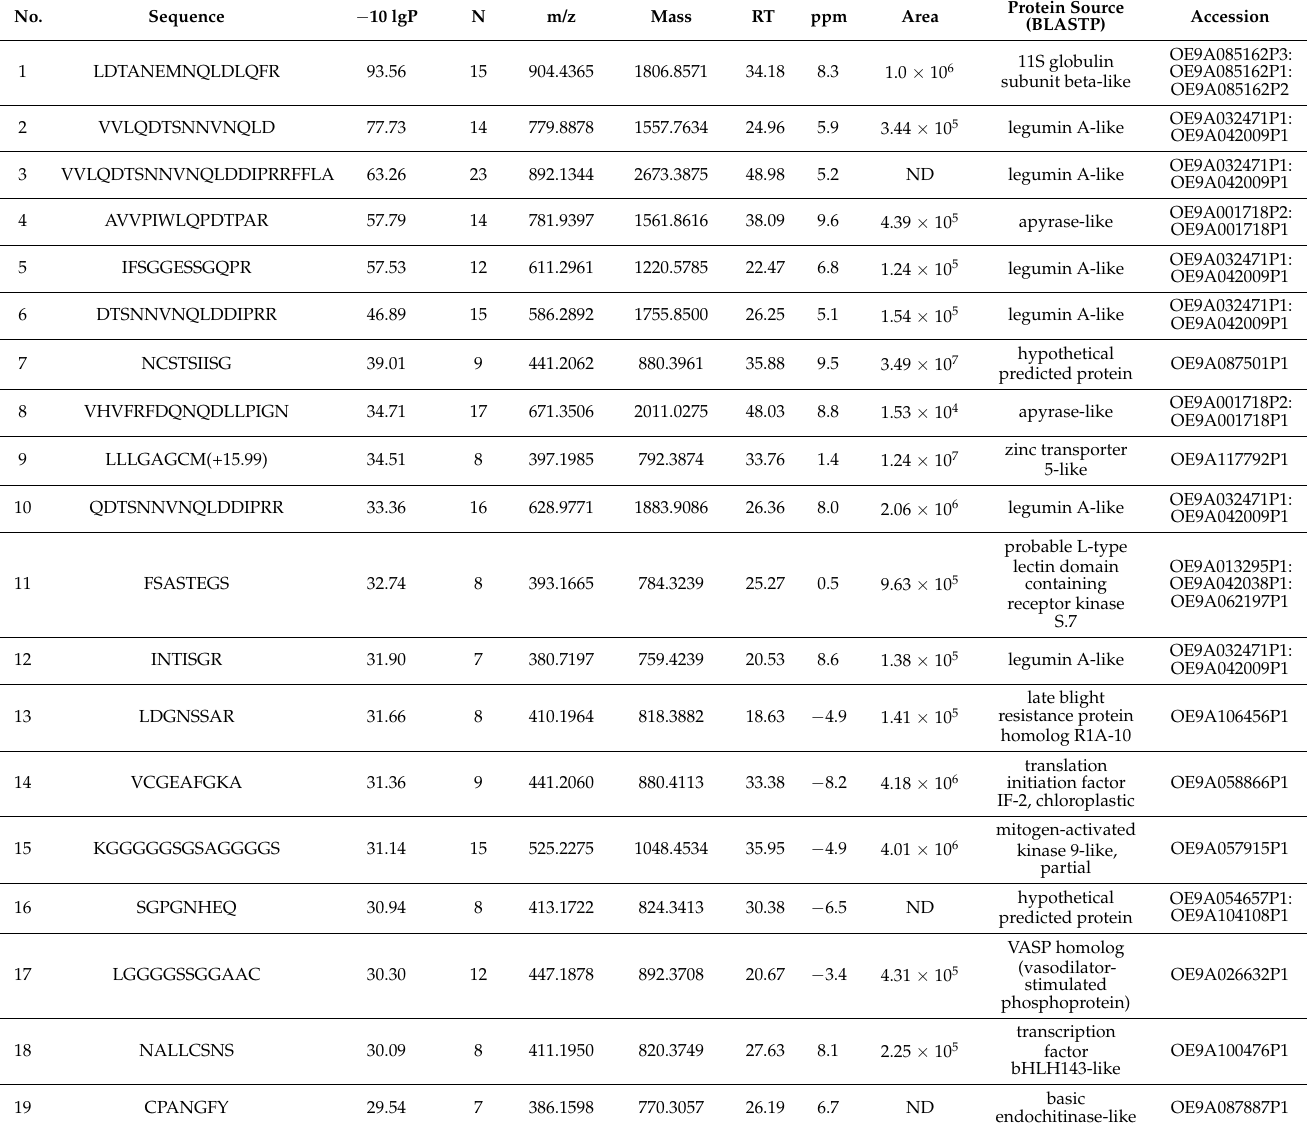
Table 1. Endogenous peptides identified in virgin olive oil using Peaks database (DB) algorithm: − 10 lgP score, statistical significance of the peptide-precursor spectrum match; N, number of amino acids; m/z, precursor mass-to-charge ratio; mass, peptide mass in Da; RT, retention time; ppm, precursor mass error; area, peptide abundance shown as area under curve of detected peptide; protein source, best-matched protein identified by BLAST-P search; accession, the accession number of the highest-scoring protein containing this peptide. Oxidised methionine is indicated by M (+15.99). ND, not